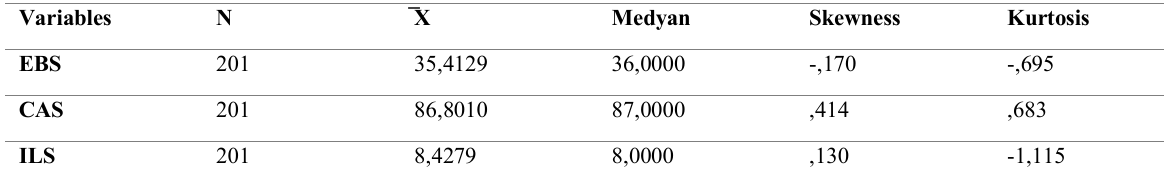
Table 2: Descriptive Statistics of the Scales